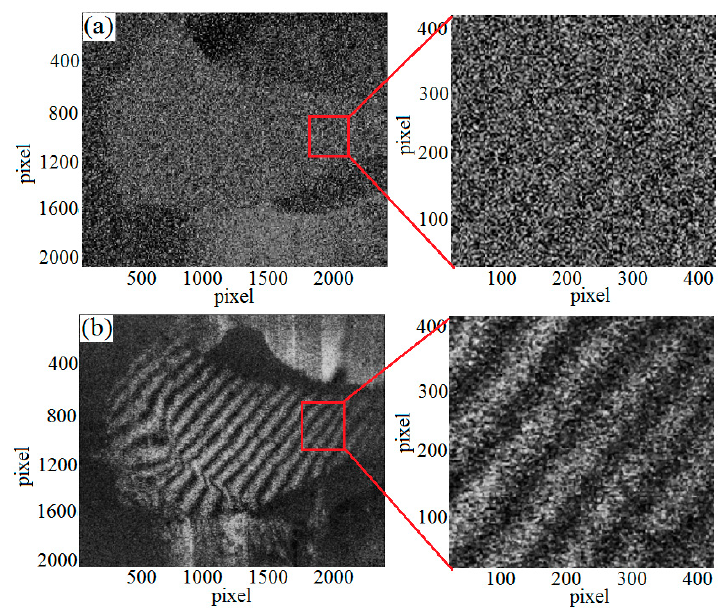
Figure 8. The interference fringe pattern ( a ) Speckle interference fringe pattern obtained in air ( b ) Speckle interference fringe pattern obtained in PBS solution.